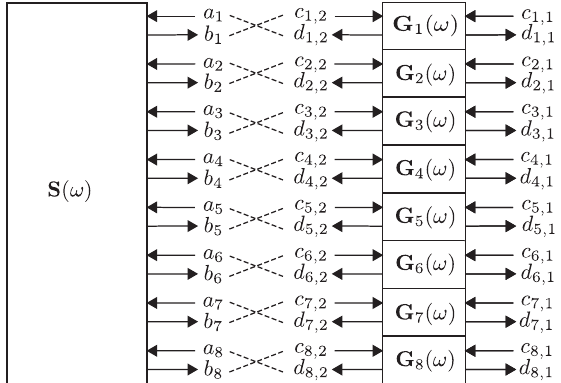
FIG. 7. Network equivalent of scattering parameter measure- ment. The block on the left-hand side shows the module ACC39 with its eight terminals and corresponding amplitudes of incident and scattered waves ( a and b ). The blocks on the right side k k show the eight cables, with their amplitudes of incident and ; and d scattered waves ( c ). The connection between the k;l k;l cables and ACC39 is shown by the dashed lines. Although not indicated in the drawing, all wave amplitudes are frequency- dependent (and complex-valued)